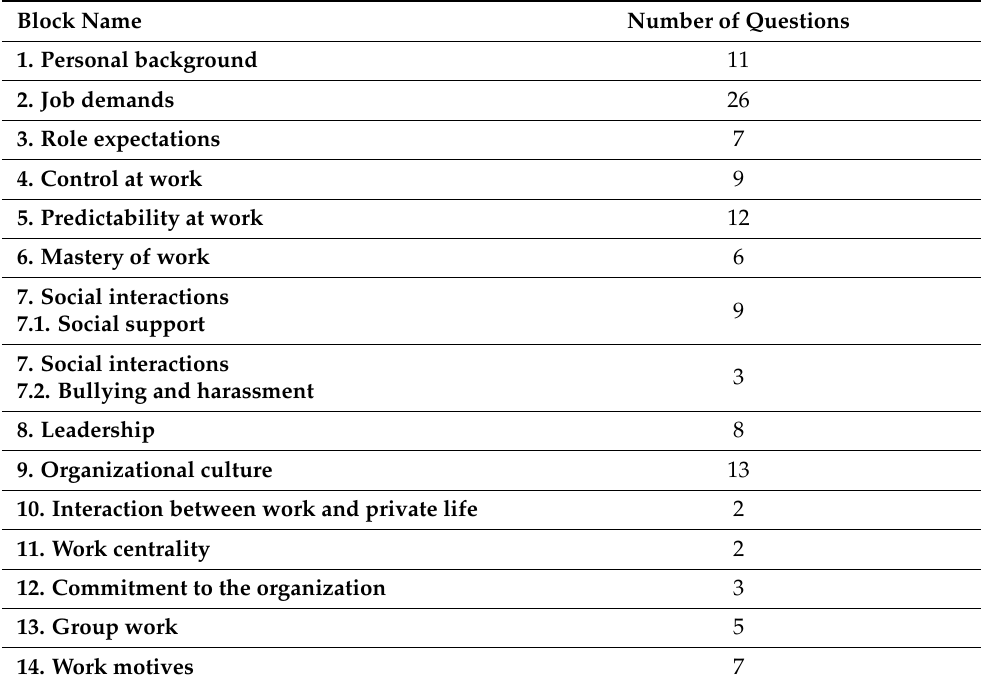
Table A1. Blocks of the QPSNordic